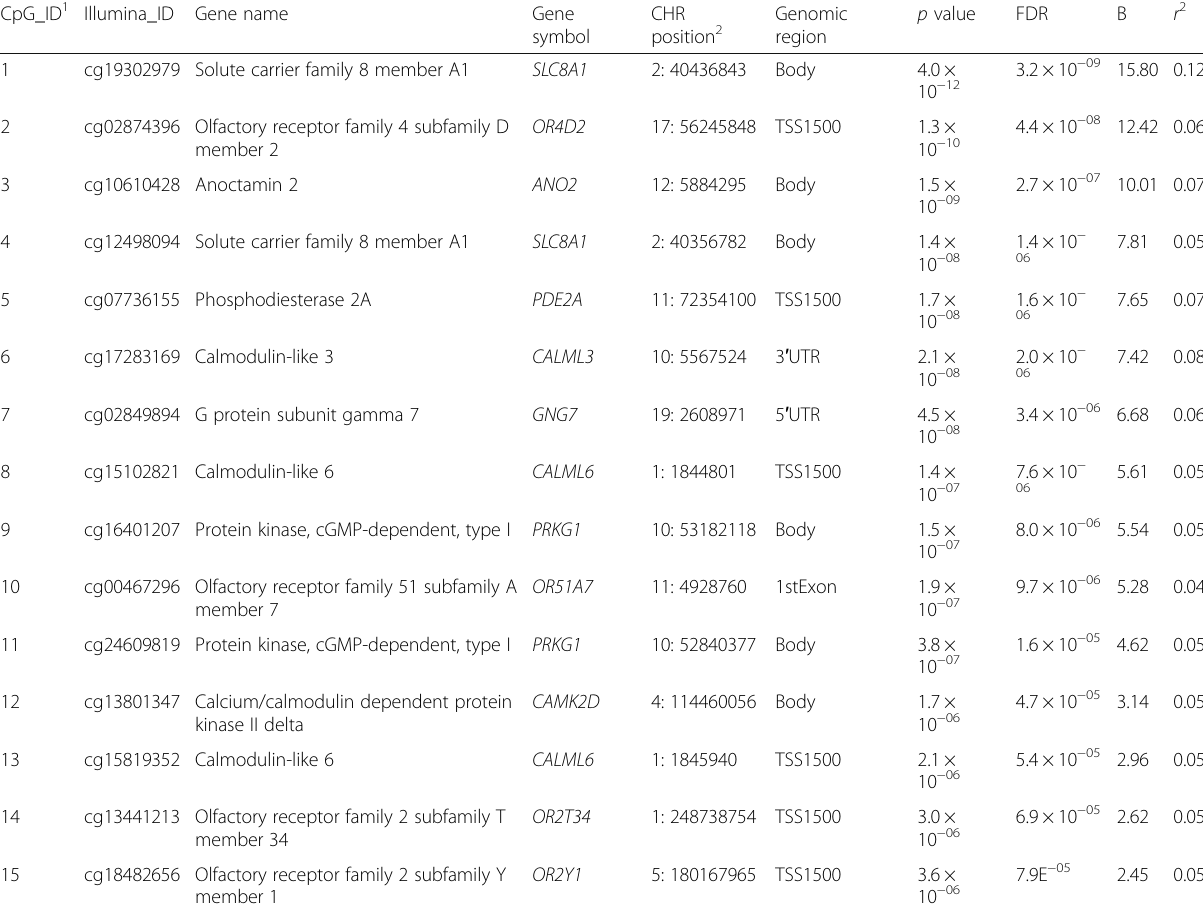
Table 2 Genomic and statistical data of CpG sites at olfactory pathway genes putatively associated with